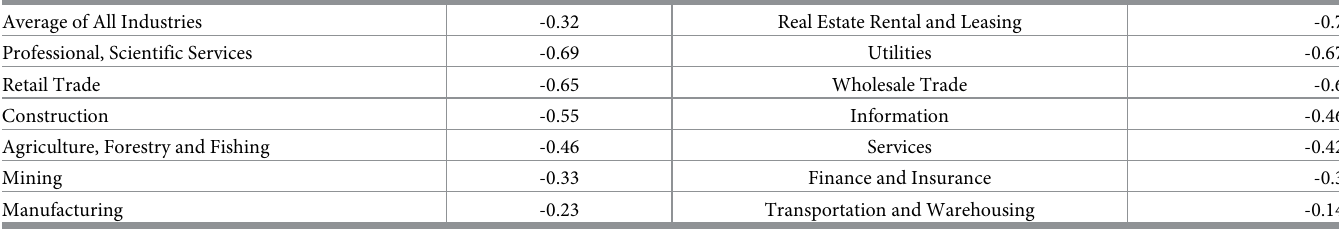
Table 1. Percentage change in the number of firms by industries,